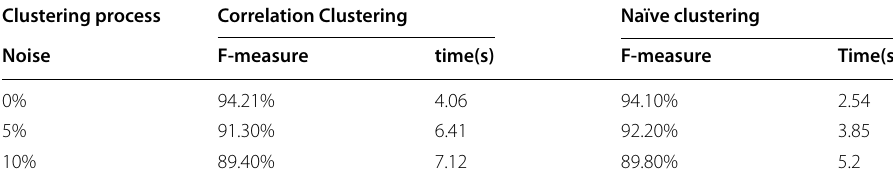
Table 4 Blocking results using address/geocode as the blocking key